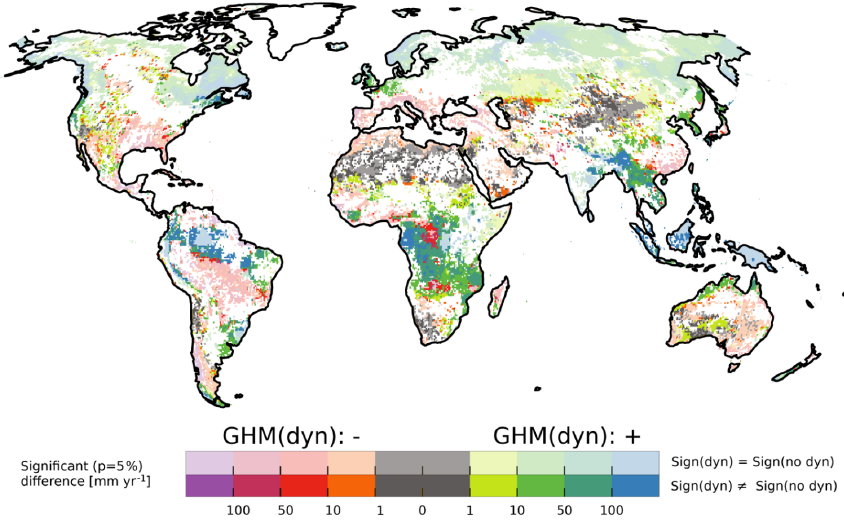
Figure 8. Significant absolute difference in GWR change between 1981–2010 and 2077–2099 for RCP8.5 in between four GHMs with (dyn) and four GHMs without dynamic (or active) vegetation (no dyn). See also Table 1. A reddish color (left side of the color bar) indicates that the mean change in GWR, as computed by the models with dynamic vegetation, is more negative or less positive than change computed by other models. White regions indicate no significance is based on the K–S test (Sect. 2.5). Solid colors indicate that the majority of the two model groups (three out of four models for each group) do not have the same sign; i.e., that including dynamic vegetation leads to different signs in the GWR change. Lighter colors indicate where the majority agrees on the sign of